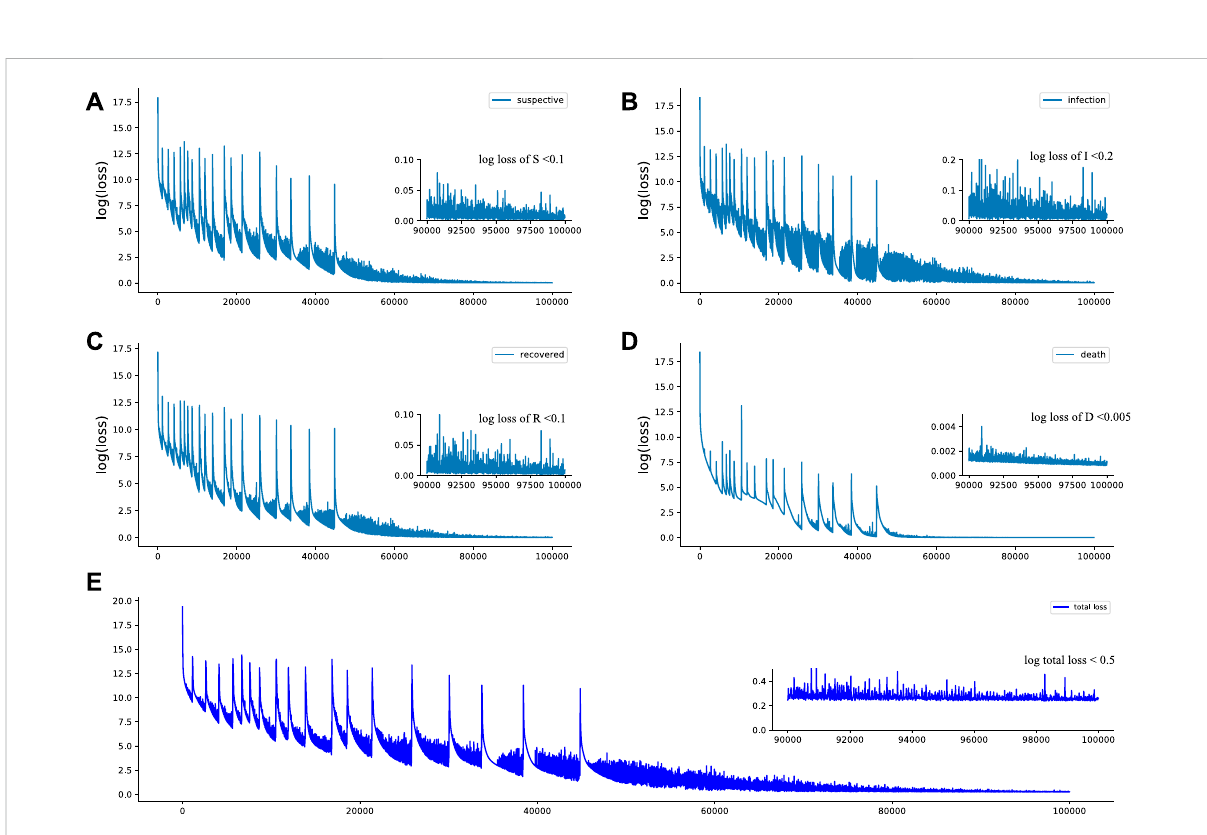
FIGURE 4 Loss of Euler-PINNs method. (A) : Loss of susceptible individuals. (B) : Loss of infection individuals. (C) : Loss of recovery individuals. (D) : Loss of death individuals. (E) : Total loss of